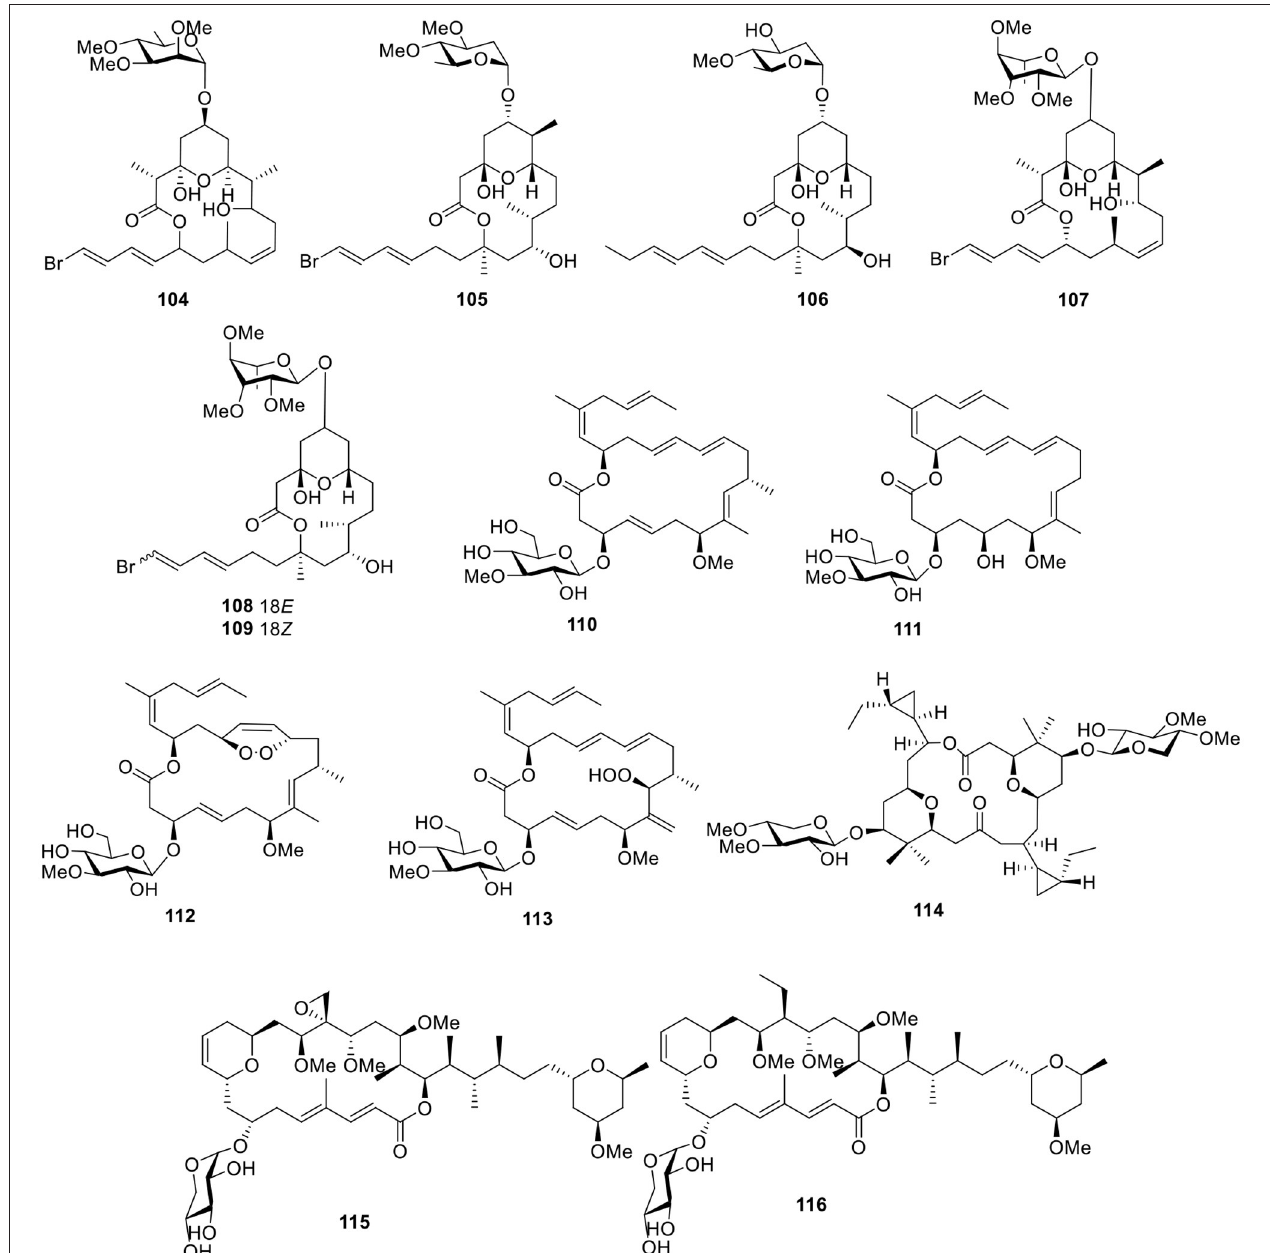
FIGURE 8 | Chemical structures of compounds 104–116 derived from marine-sourced cyanobacteria.